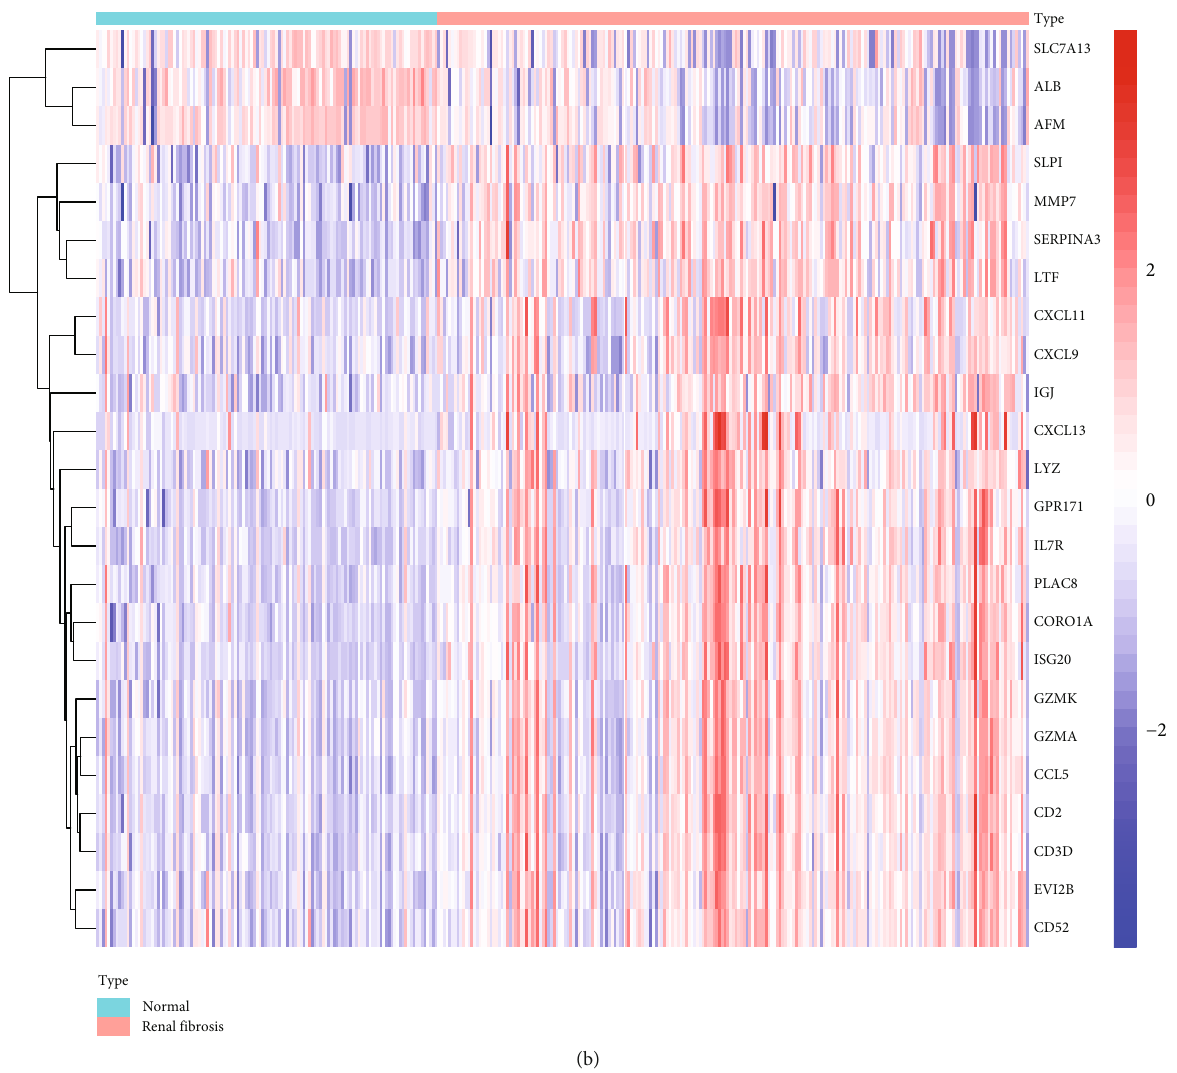
Figure 1: Volcano plot (a) and heat map (b) of di ff erentially expressed genes between renal fi brosis specimens and healthy